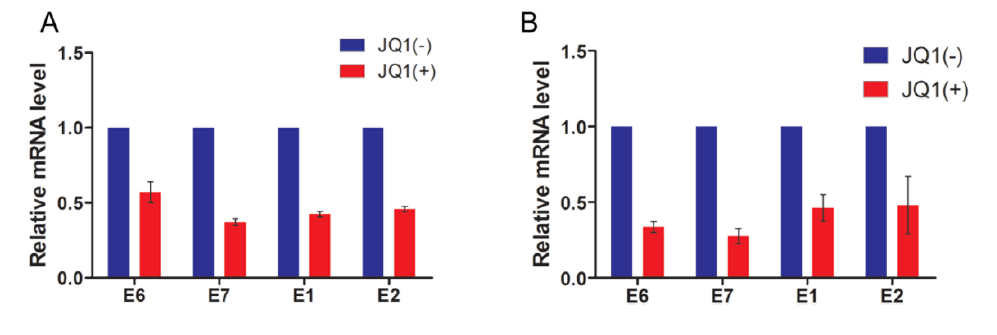
Figure 5. JQ1(+) treatment inhibits papillomavirus early gene expression. ( A ) H2 cells were treated with 1 μM JQ1(–) or JQ1(+) for 15 h. RNA from these cells was reverse transcribed and the levels of the indicated BPV1 early gene mRNAs were measured by RT-qPCR. The mRNA level for each viral gene was normalized to GAPDH mRNA level. The JQ1(+)-treated sample values are presented relative to the JQ1(–) sample values; ( B ) W12 (clone 20863) cells were treated with 100 nM JQ1(–) or JQ1(+) for 15 h. As in ( A ), RNA was collected and reverse transcribed and the cDNA was used in RT-qPCR analyses to measure HPV16 early gene mRNAs. The mRNA level for each viral gene was normalized to GAPDH mRNA level. The JQ1(+)-treated sample values are presented relative to the JQ1(–) sample values. For ( A ) and ( B ), average and standard deviation were calculated from three independent